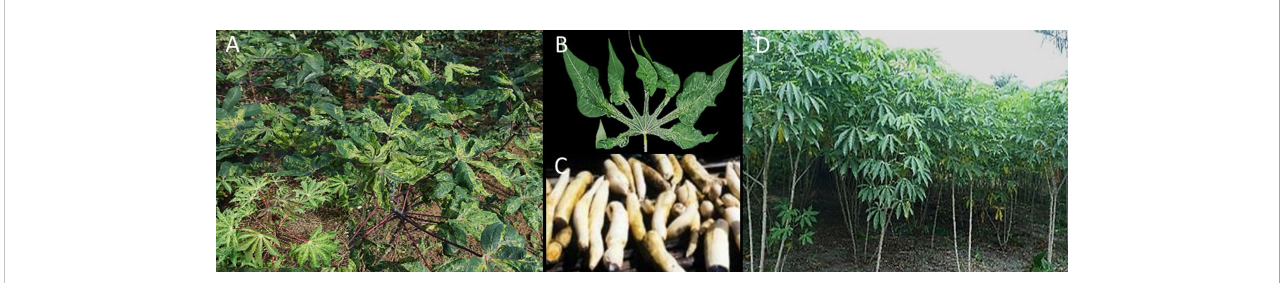
FIGURE 1 Severe mosaic symptoms of CMD (A) , leaf deformation (B) , and plant stunting in sensitive varieties result in small-sized root tubers (C) . The disease does not affect the highly resistant cassava variety TME 419 growing in an open fi eld near Yangambi, DR Congo (D)